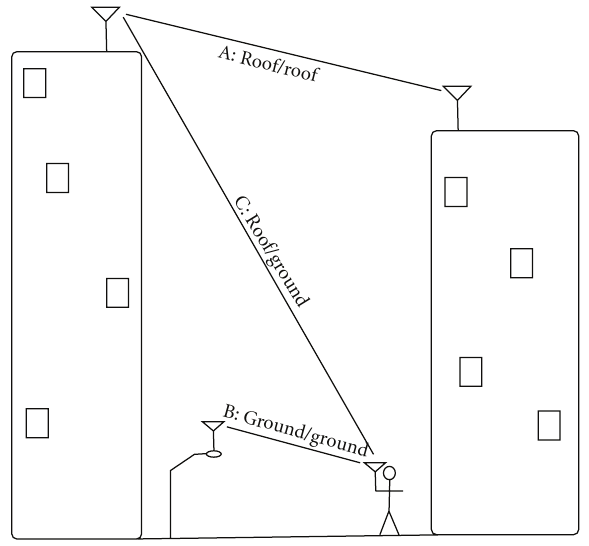
Figure 2: Visual schematic of three urban data sets. A: roof-to-roof measurements from CU WART (Wide area radio testbed), B: ground- (utility poles) to-ground (mobile node) measurements in Portland, and C: roof-to-ground and ground-to-roof measure- ments from CU WART.